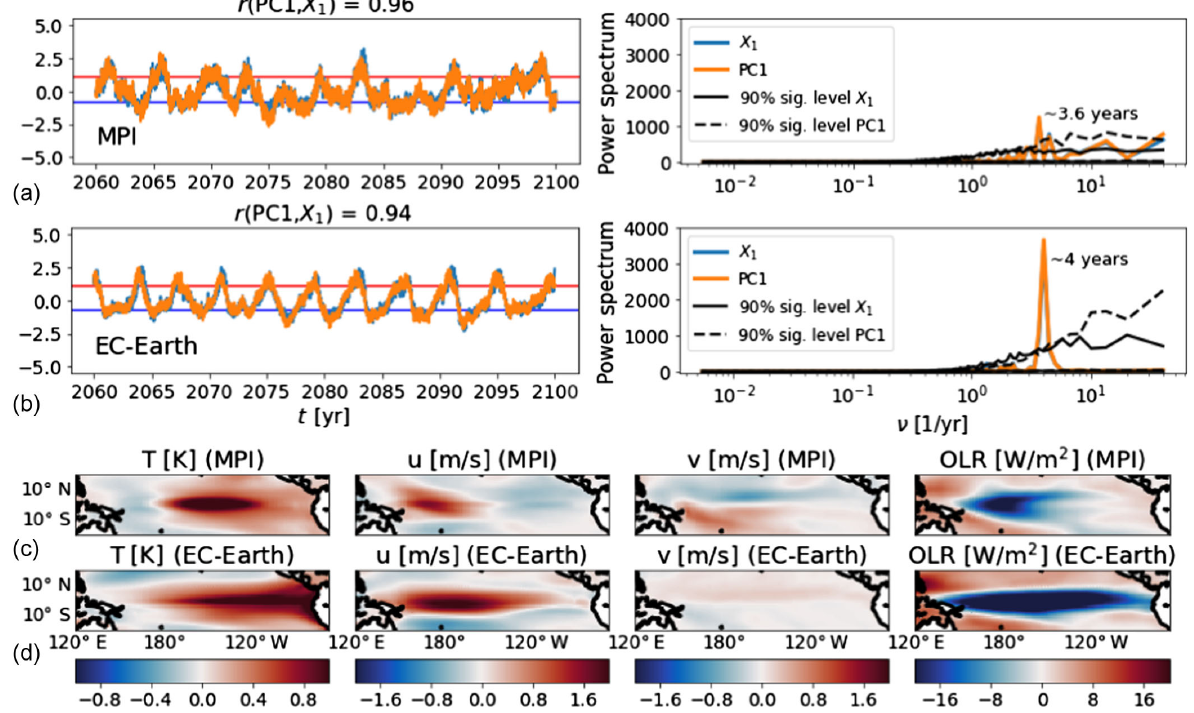
FIG. 16. (a),(b), left-hand column: first (standardized) Isomap ( X 1 ) and principal component (PC1) for the two CMIP6 models (MPI and EC-Earth). Red (blue) lines represent the median of positive (negative) values in the 0.1 quantile (10th percentile) of the joint PDF of d and θ (see Fig. 5). Right-hand column: Fourier spectra. The spectral significance has been tested under the null hypothesis of red noise [96 – 98]. (c),(d) Projection of the first (embedded) Isomap component on the modeled datasets. The period analyzed is 2060 – 2100 under the SSP585 scenario.